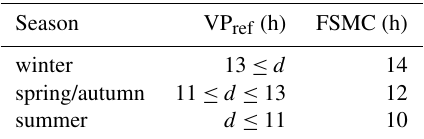
Table 2. Nighttime durations ( d ) for the different seasons for esti- mations of regime statistics from the VP ref and corresponding aver- age durations for calculations in a